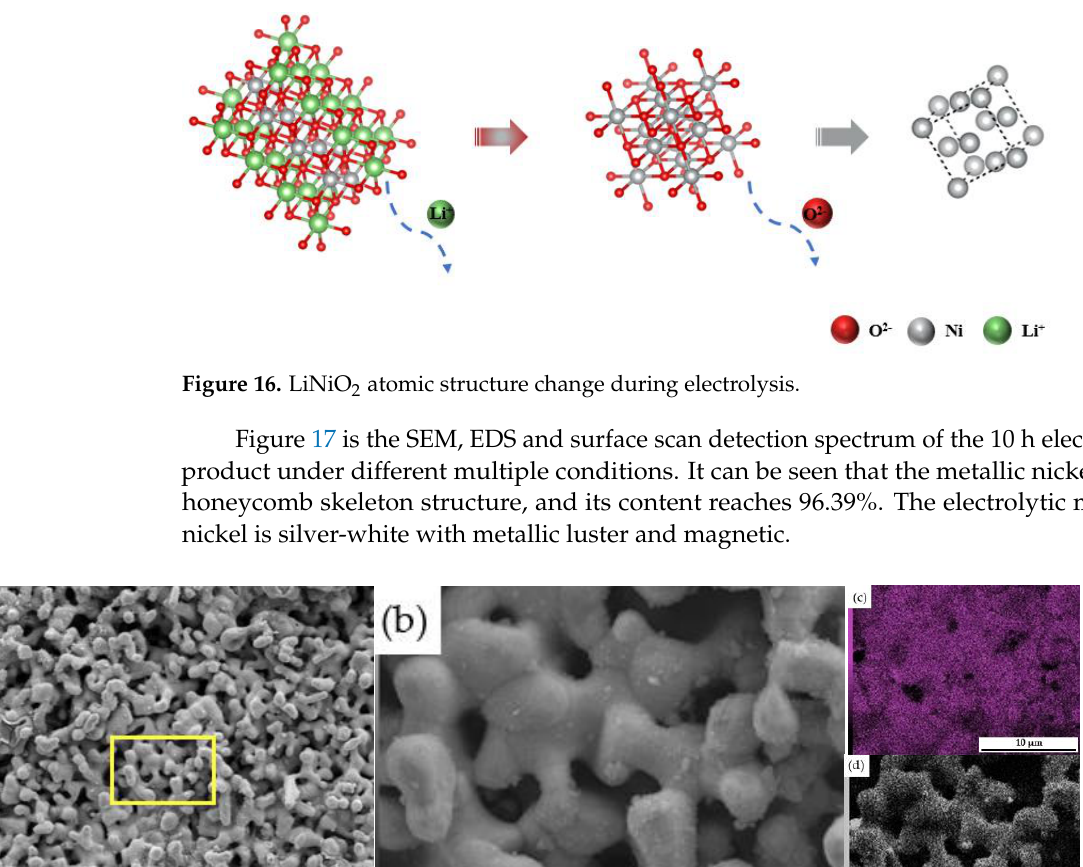
Figure 18. XPS test results of the product after 0.13 A electrolysis for 4 h.